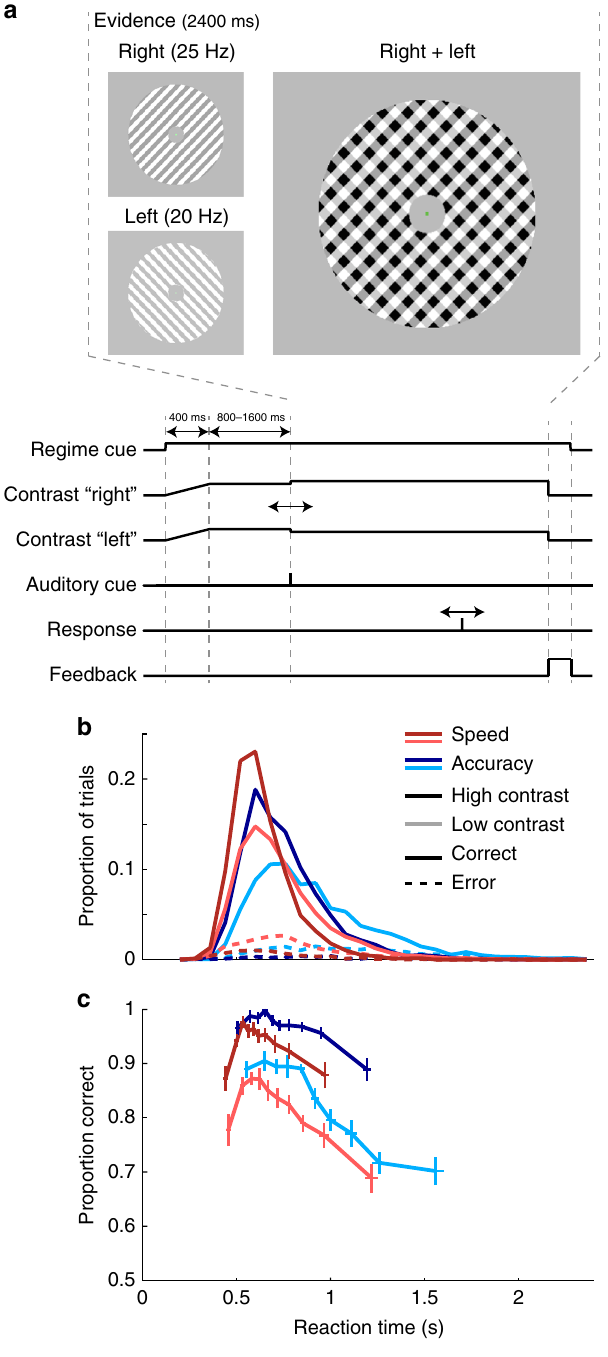
with the presence of a dynamically growing urgency component operating in both regimes 11 . The rate of accuracy decline over RT did not differ signi fi cantly as a function of Regime (slope of a line fi t to response accuracy over 8 RT bins lying beyond each sub- ject ’ s point of maximum response accuracy, ANOVA, F (1,15) = 1.7, p = 0.22, Supplementary Table 4c), although the evidence for equivalence was not strong (BF 01 = 2.197).